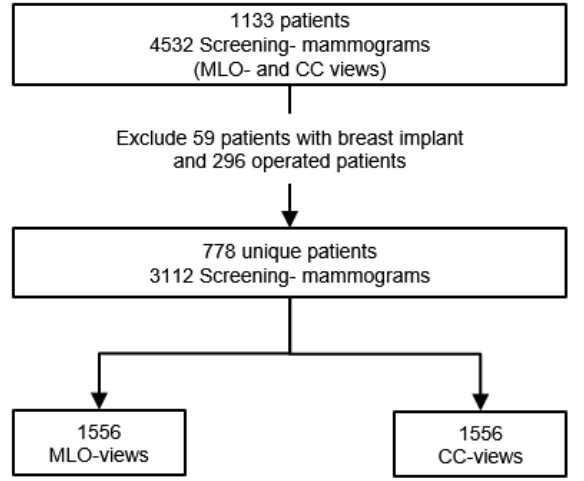
Figure 2. Flowchart of collected digital mammography studies. From 4532 screening mammograms a set of 3112 exams was selected after excluding mammography examination of operated patients and patients with breast